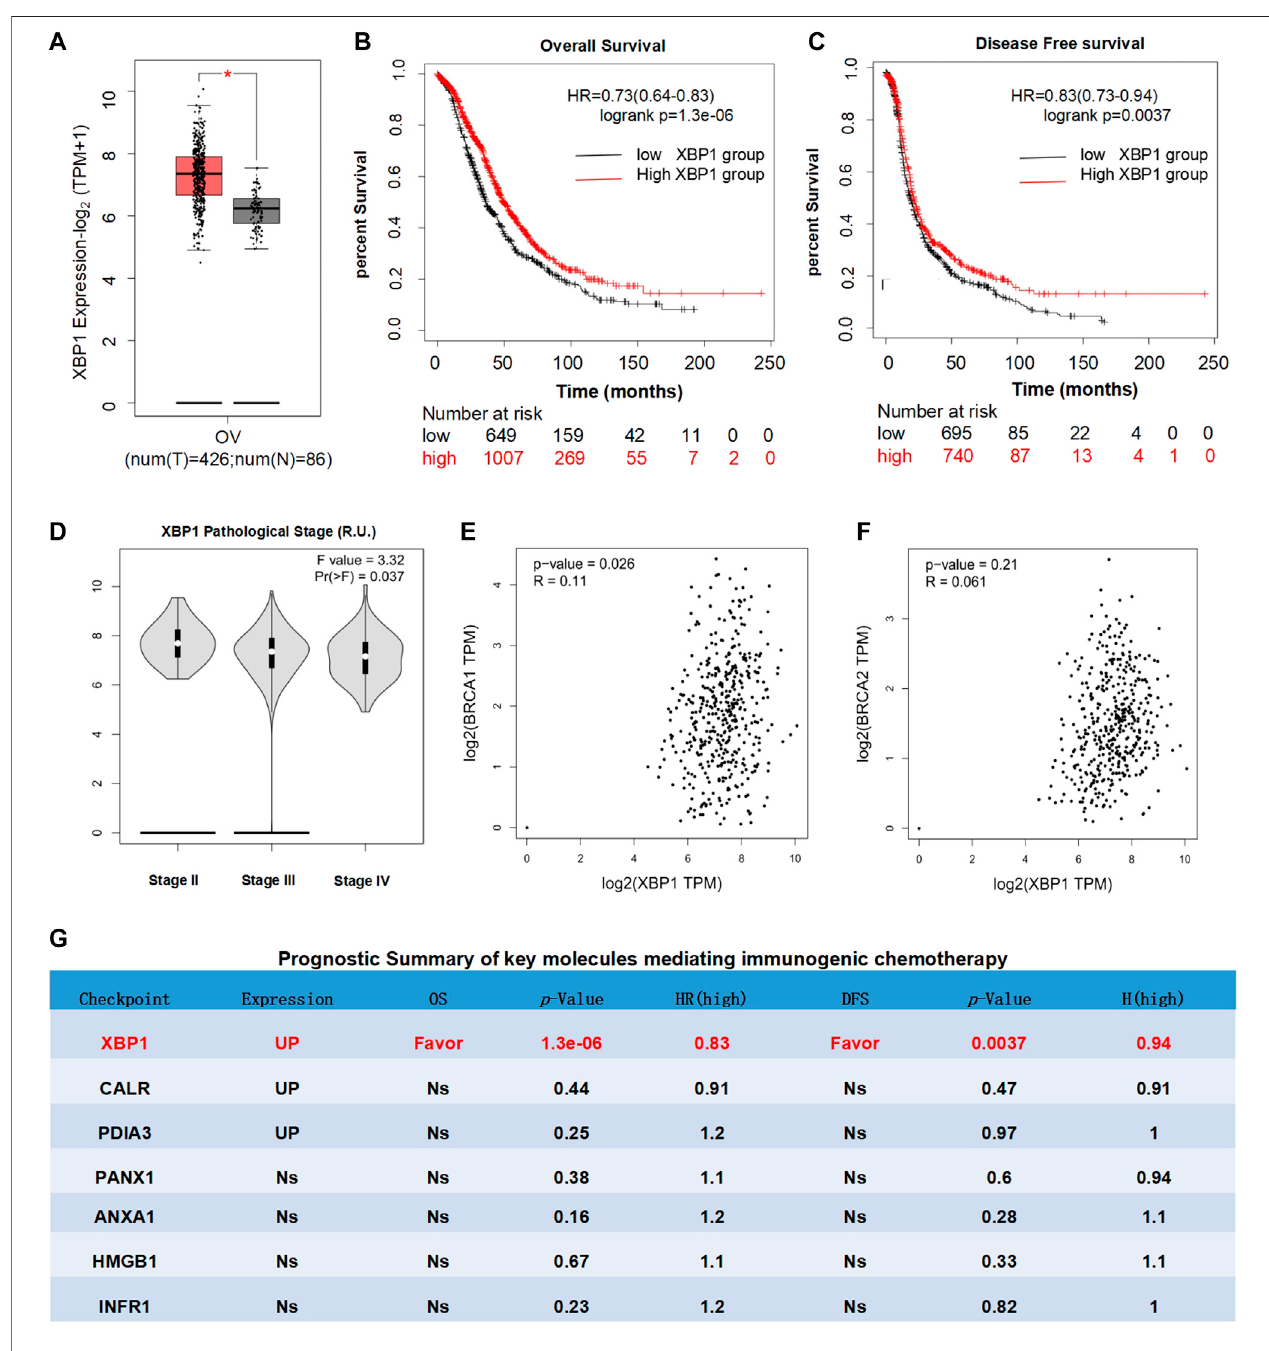
FIGURE3| PrognosticanalysisofXBP1inovariancancer. (A) DifferentialexpressionanalysisofXBP1inovariancancer.Boxplotswithjitter(size=0.5)forcomparingXBP1 (A) expressioninovariancancerandnormalovariantissuesweremadebyGEPIA.T,tumorsamples;N,normalsamples.One-wayANOVAwasusedfordifferentialanalysis.Geneswith higher |log2FC| values ( > 1) and lower q-values ( < 0.01) were considered to be differentially expressed genes. (B) OS analysis of XBP1 in ovarian cancer. (C) DFS analysis of XBP1 in ovariancancer.Kaplan-meierPlottergeneratesKaplan-MeierOS (B) andDFS (C) curvescomparingthegroupswithdifferentexpressionlevelsofXBP1inovariancancer.Blue line:low-expressiongroup;redline:high-expressiongroup.Log-ranktestwasusedforhypothesistest.TheCox-proportionalhazardratioandthe95%con fi denceintervalinformation werealsoincludedinthesurvivalplots.Thestaticallysigni fi cantdifferencewasconsideredwhena p -valueis < 0.05. (D) .DifferentpathologicalstagesanalysisofXBP1inovariancancer. Differential expression of log-scaling in different pathological stages was assessed by log2(TPM+1), and a Pr ( > F) < 0.05 was considered to be statistically signi fi cant. (E) Correlation analysisofBRCA1andBXP1inovariancancer. (F) CorrelationanalysisofBRCA1andBXP1inovariancancer.Thepair-wisegeneexpressioncorrelationsoftwogenesweremadeby GEPIA, or between one gene and BRCA1/BRCA2in ovarian cancer (TCGA tumor) using Spearman method. The detailed p -value and R were individually presented as indicated in eachpanel.Thestaticallysigni fi cantdifferencewasconsideredwhena p -valueis < 0.05. (G) PrognosticSummaryofkeymoleculesmediatingimmunogenicchemotherapy.Thedetailed differential expression pro fi le, OS, DFS, p -value, and HR (high) of key molecules mediating immunogenic chemotherapy were individually summarized as indicated. The statically signi fi cant difference was considered when a p -value is < 0.05. (Up: upregulated in tumor; Favor: favorable to survival; Unfavor: unfavorable to survival; Ns: nonsigni fi cant).